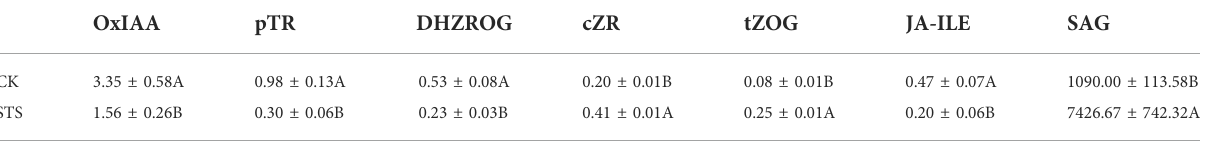
Note: Data are the means (ng/g) of three replicates ±SD. Different letters indicate a signi fi cant difference at the 1% level, as determined by Duncan ’ s new multiple-range test. OxIAA,2-oxindole-3-aceticacid;pTR,para-topolinriboside;DHZROG,dihydrozeatin-O-glucosideriboside;cZR,cis-zeatinriboside;tZOG,trans-zeatin-O-glucoside;JA-ILE,jasmonoyl- L-isoleucine; SAG, salicylic acid 2-O- β